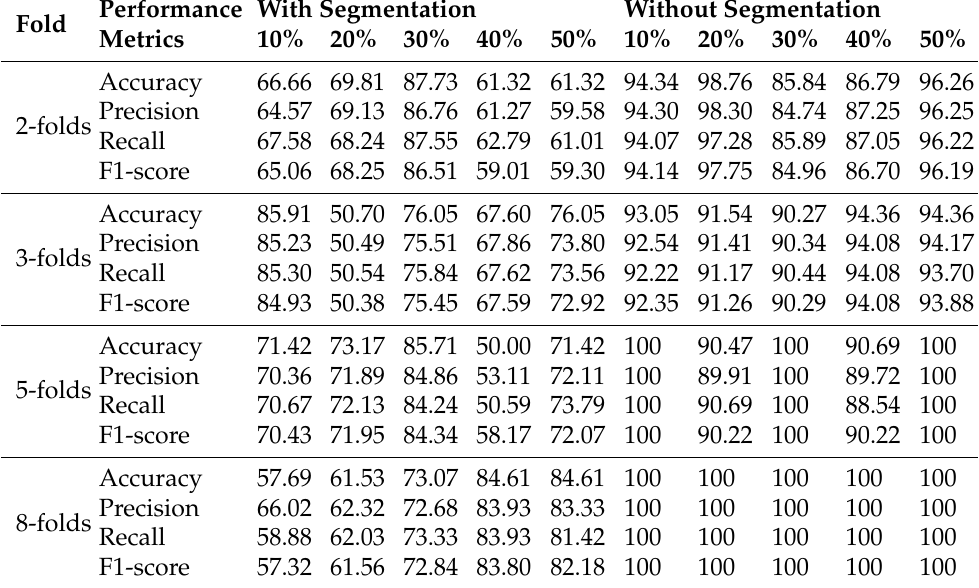
Table 7. Performance metrics for 10%, 20%, 30%, 40% and 50% testing data using Redundant frame extraction for with and without segmentation for two, three, five, and eight